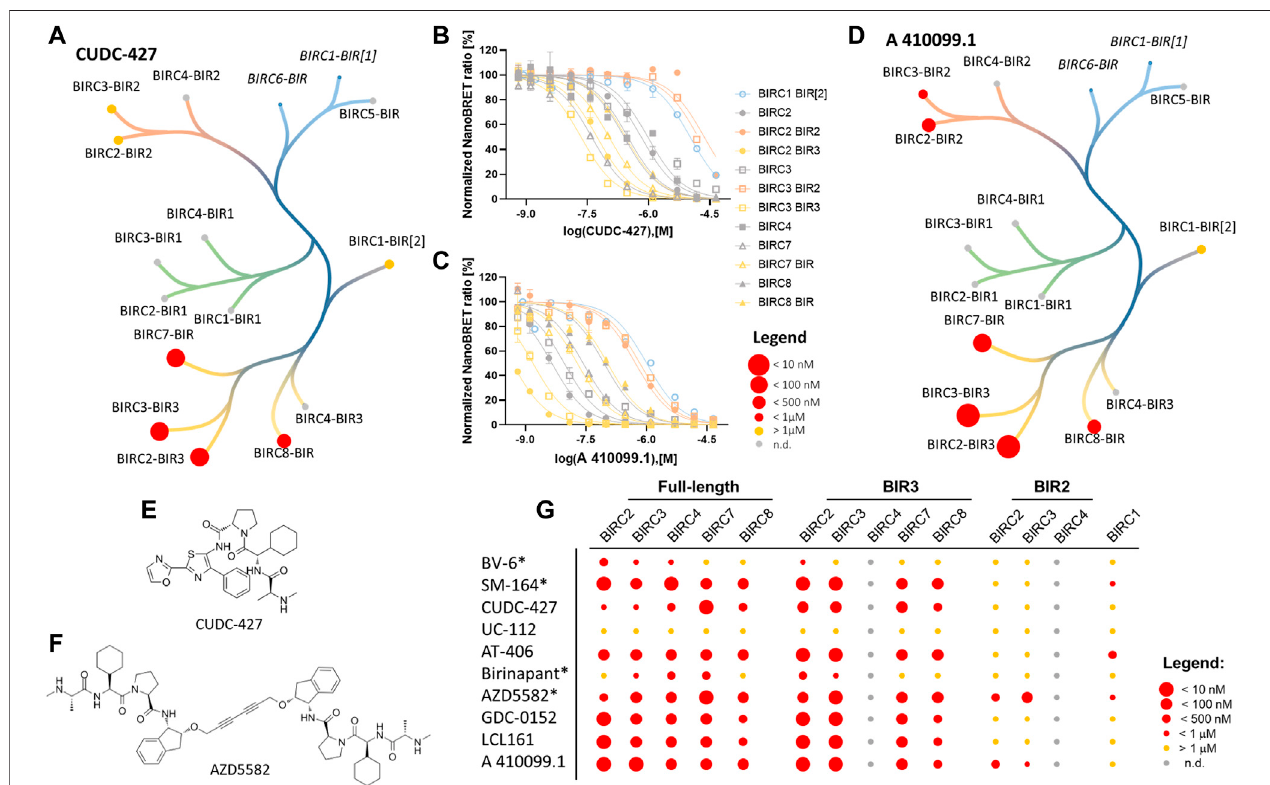
FIGURE 4 | NanoBRET cellular target engagement assay using the full-length and single domain proteins. Full-length BIRC2, BIRC3, BIRC4, BIRC7, BRIC8, and BIRC1-BIR2, BIRC2-BIR2, BIRC2-BIR3, BIRC3-BIR2, BIRC3-BIR3, BIRC7-BIR and BIRC8-BIR were investigated. Data were expressed as mean ± SEM using two independent experiments performed in duplicates ( n = 4). (A) Potency of CUDC-427 against tested BIRC domains. The excluded assays for BIRC6-BIR and BIRC1- BIR1 are shown in italic. (B,C) Normalized NanoBRET ratio [%] against the tested concentration of CUDC-427 and A 410099.1, respectively. (D) Potency of most potent compound A 410099.1 against tested BIRC domains. The excluded assays for BIRC6-BIR and BIRC1-BIR1 are expressed in italic. (E,F) chemical structures of CUDC-427 and AZD5582 which mark starting points towards BIRC7 selective inhibitors. (G) Heat map for compound potencies towards the corresponding protein constructs. Bivalent compounds are marked (*).